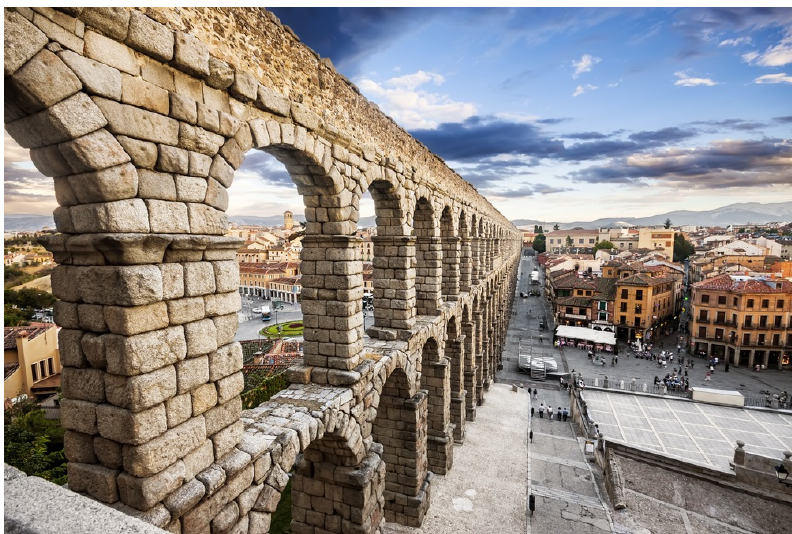
Figure 4. Aqueduct of Segovia (Spain). Granite ashlars without mortar.